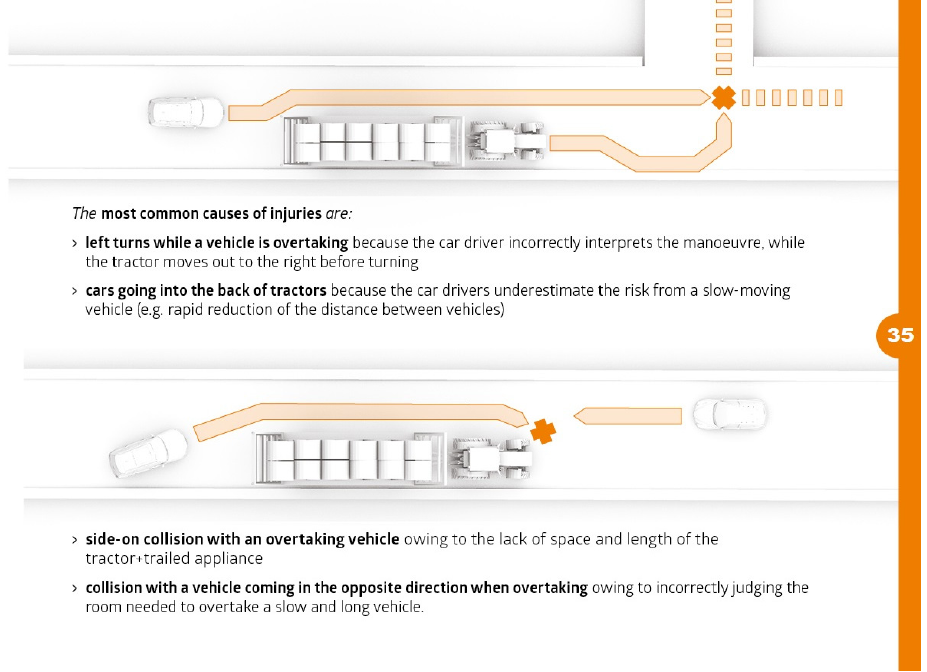
Figure 12. Example of a figure summarizing real cases of fatalities .